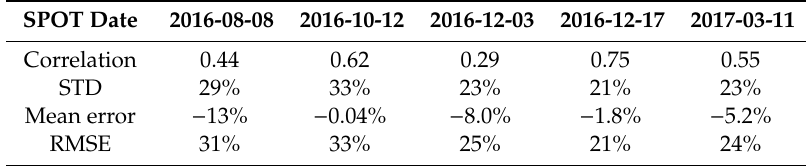
Evaluation of the Sentinel-2 FSC against the SPOT FSC (dates are given in format year-month-day).